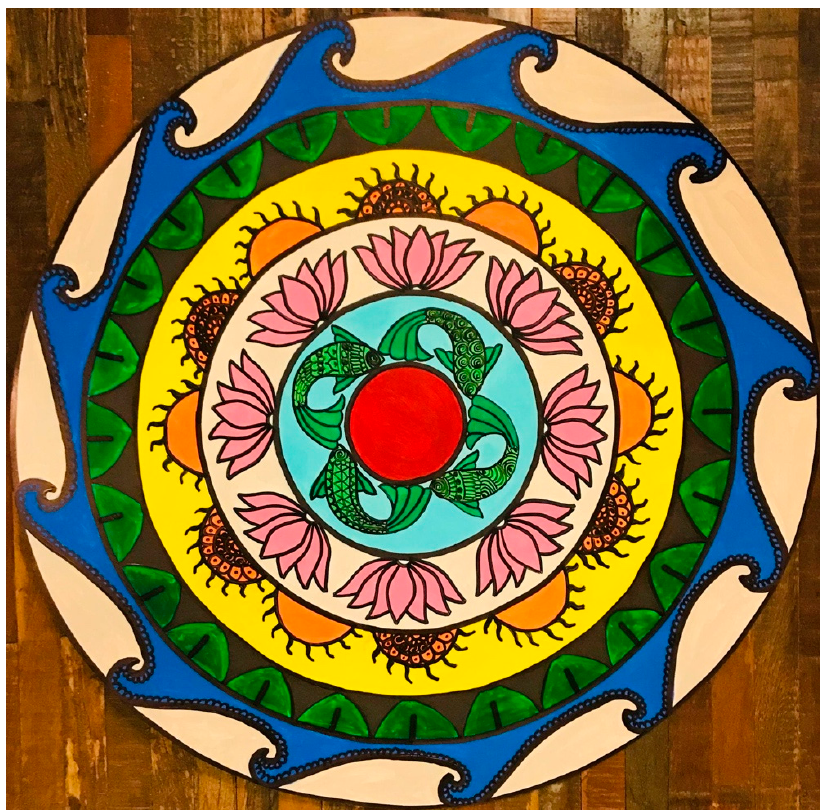
Figure 4. Chinmayi Shukla (PSU ’24, and a student in my Asian religions course). “Shapes of Shakti.” Acrylic and kumkuma powder on paper, 2020.